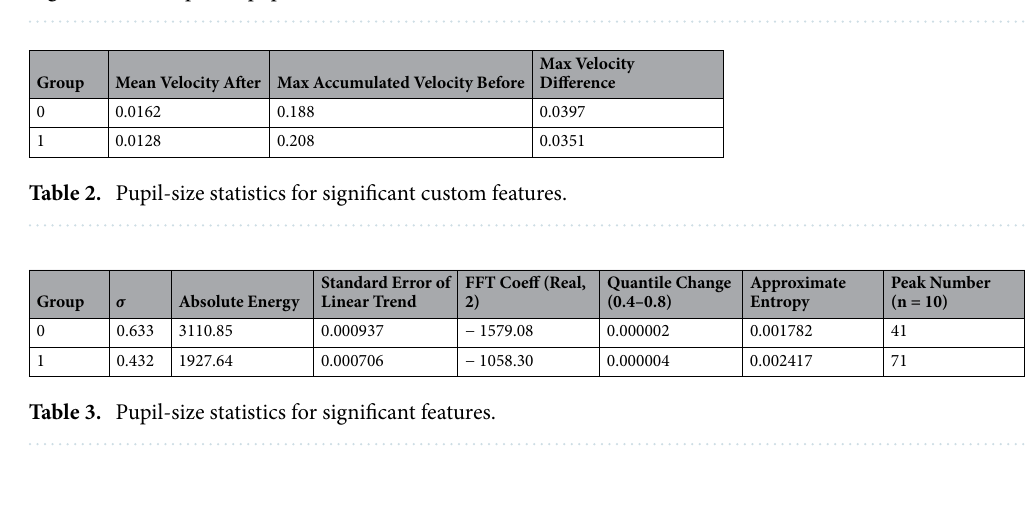
Figure 7. Violin plot of pupil-size standard deviation.